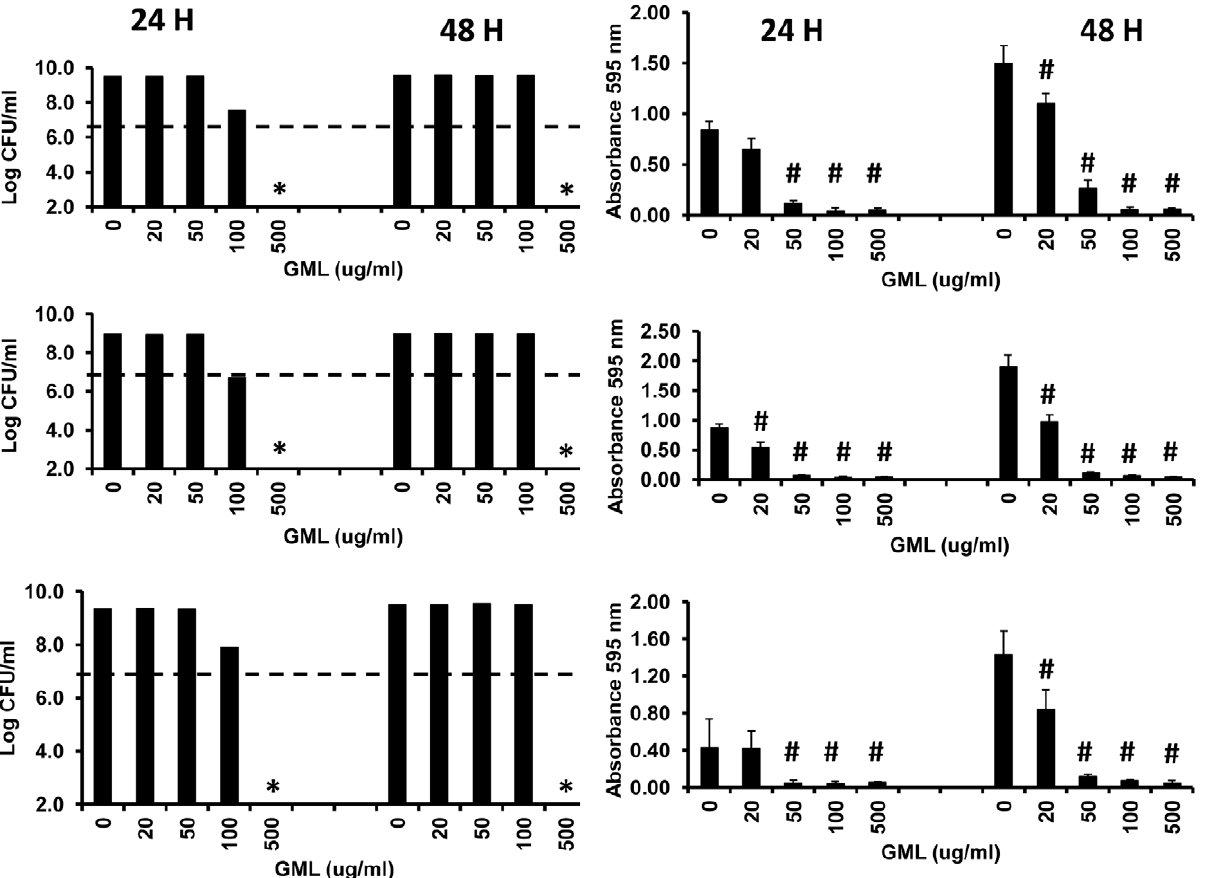
Figure 7. Effect of GML on three Staphylococcusaureus strains cultured in biofilms. Staphylococcus aureus strains methicillin-sensitive MN8, community-associated methicillin-resistant MNWH, and community-associated methicillin-resistant MW2 were cultured for 24 and 48 hours in 96 well microtiter plates. In one set of three wells for each microbe, the wells were agitated 3 times by pipetting up and down. CFU/ml were determined on supernates then removed from the wells. * indicates significant mean reduction compared to starting inoculum mean at p , 0.001. Dashed line indicates starting inoculum size. Subsequent to removing unbound cells and then washing wells three times with phosphate-buffered saline, the wells were treated with crystal violet for 30 min. The wells were next washed three times with phosphate-buffered saline to remove unbound crystal violet. Finally, wells were treated with ethanol to solubilize biofilm-associated crystal violet. Absorbances at 595 nm were determined by an ELISA reader. # indicates significant mean reduction in absorbance at 595 nm wavelength between no GML and GML-treated wells at p ,